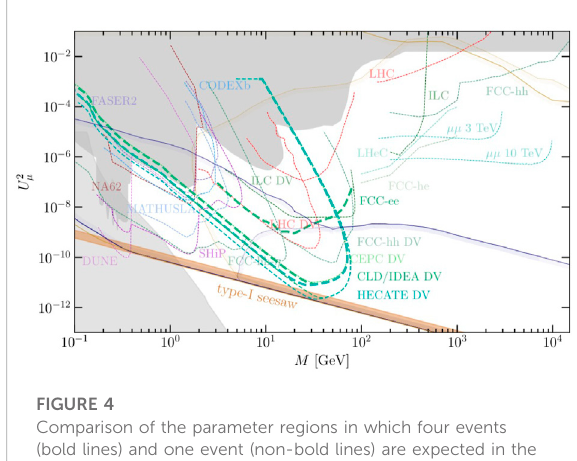
FIGURE 3 Bold green line : Sensitivity of displaced vertex searches at FCC-ee. The parameter region inside the curves corresponds to more than four observed HNL decays with | V ℓ N | 2 (cid:1) δ ℓ μ U 2 μ from 5 × 10 12 Z bosons, assuming no background events and 95% reconstructed HNL decays (i.e., all decays except the invisible